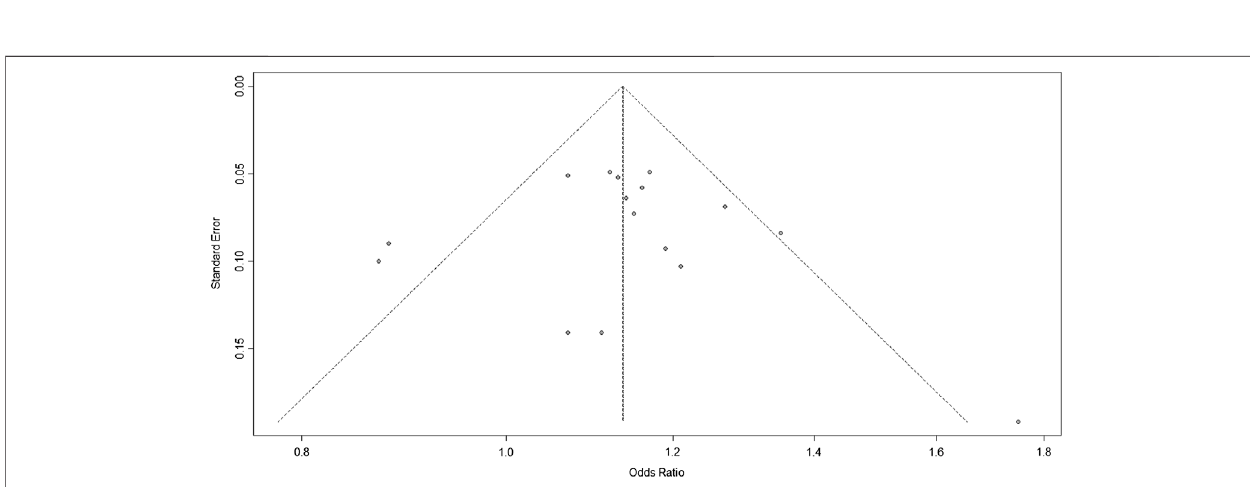
FIGURE 3 | Funnel plots corresponding to the random-effects meta-analysis of all studies of the three single-nucleotide polymorphisms (SNPs; rs2383207, rs2383206, and rs10757278) and ischemic stroke (IS).